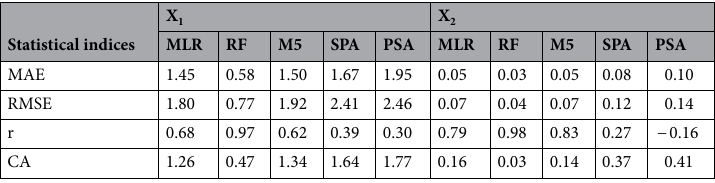
Table 4. Statistical indices for estimating X 1 and X 2